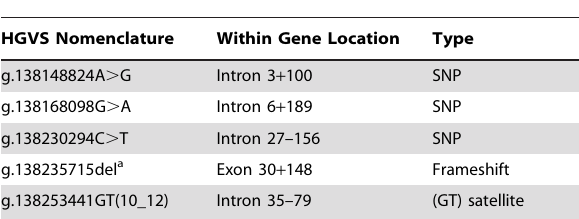
Table 1. Polymorphisms identified in the MYO5A sequence. Table 2. Association of Lavender Foal Syndrome with ECA1